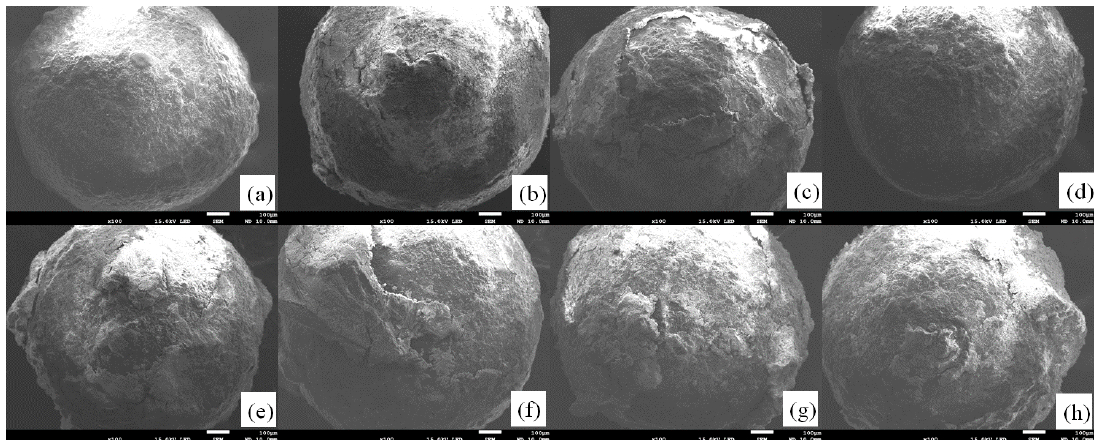
Figure 8. Complete diagram of the prepared Co 2+ /Al 2 O 3 catalyst.